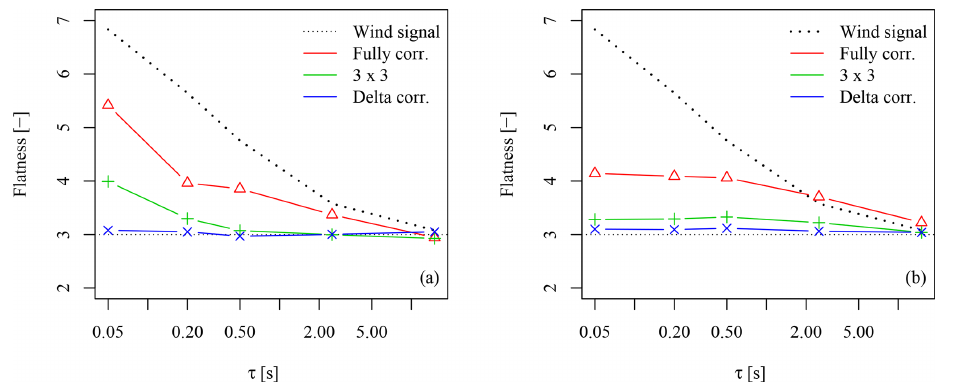
Figure 13. Flatness of load increment PDFs for intermittent fields with different spatial dynamics: (a) for the rotor thrust; (b) for the